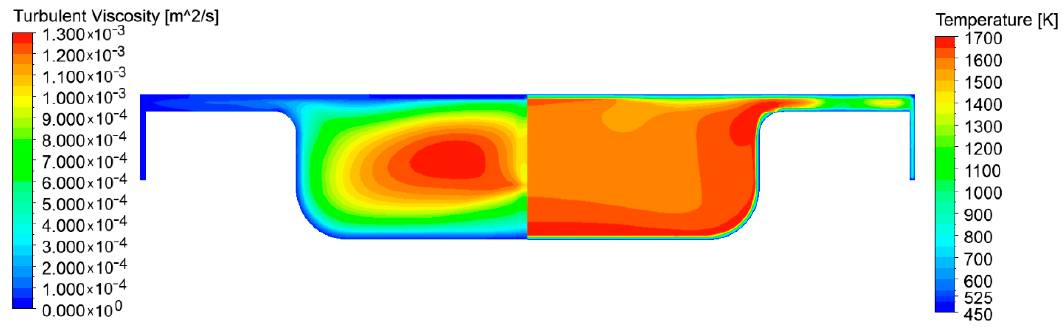
Figure 6. Turbulent gas diffusivity ( left ) and temperature ( right ) contour plots at 10 CAD ATDC.